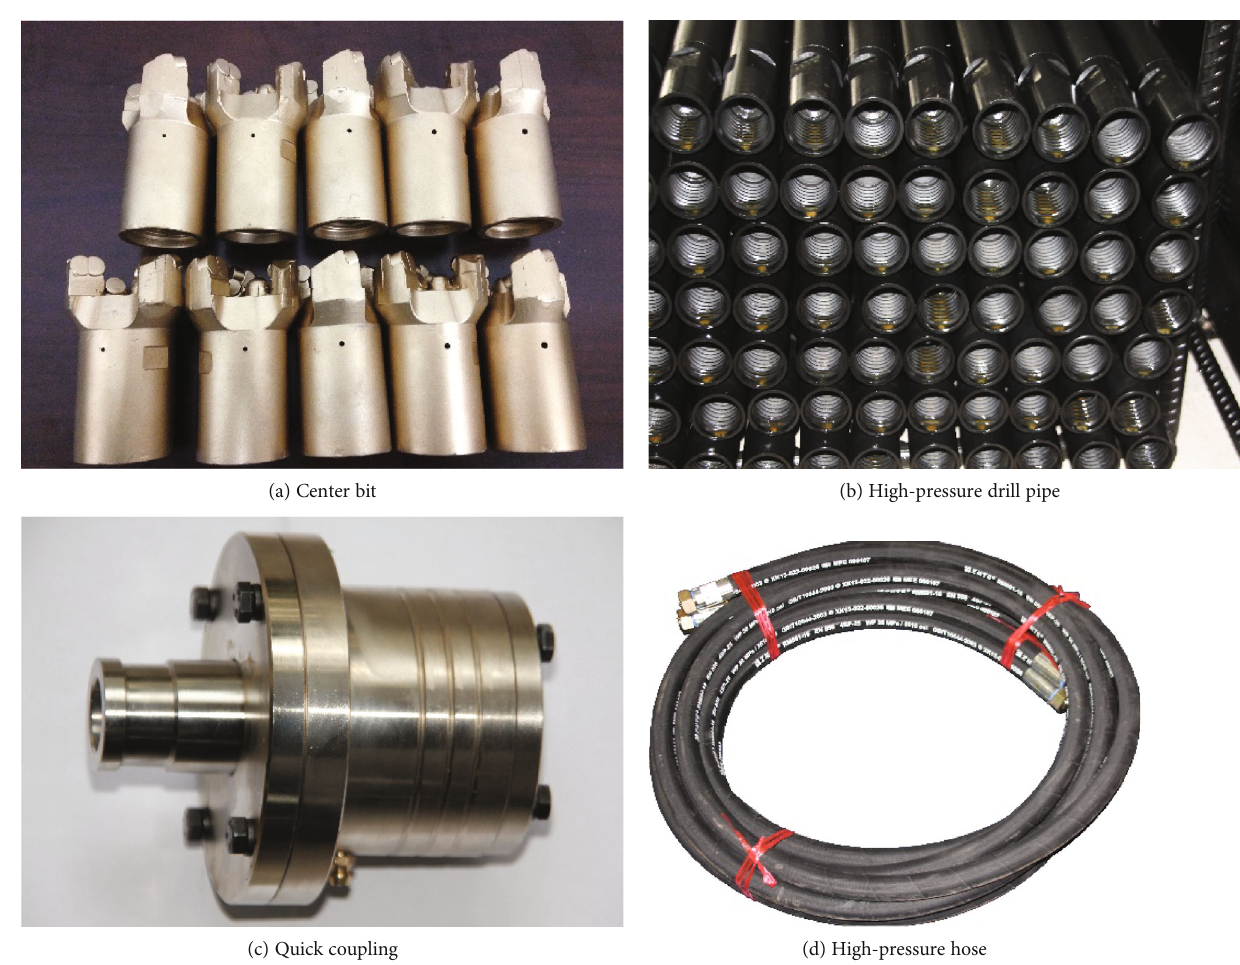
Figure 6: Main components and physical